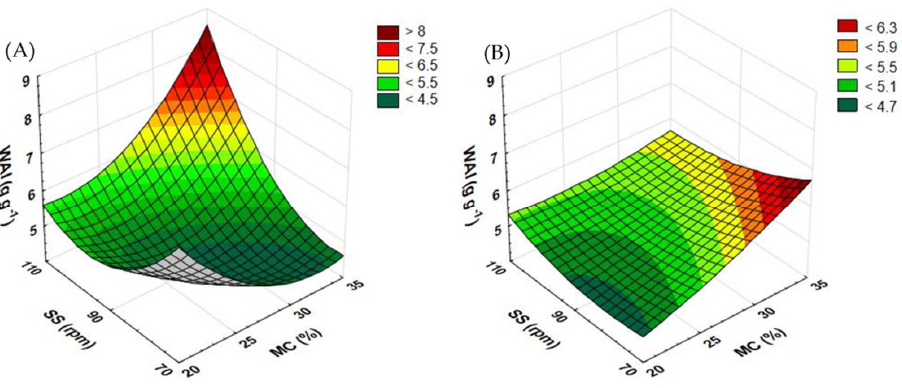
Figure 8. The results of WAI measurement for extruded rapeseed straw ( A ) and buckwheat straw ( B ) before modification of the plasticizing system: MC—moisture content; SS—screw speed; WAI— water absorption index.